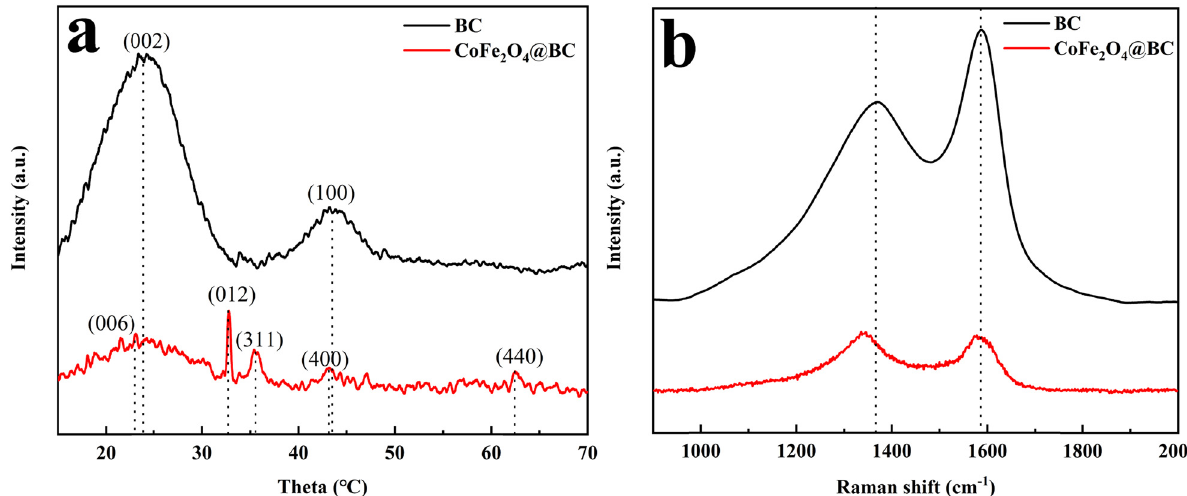
Figure 1: ( a ) XRD patterns and ( b ) Raman shifts of BC and CoFe 2 O 4 @BC.